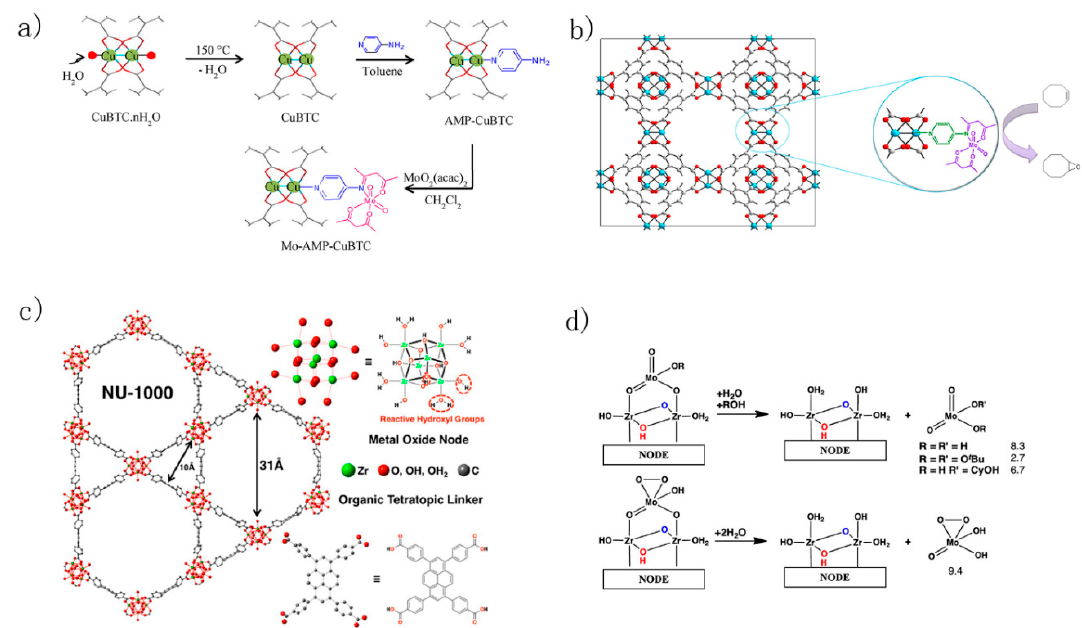
Figure 2. ( a ) The schematic process for modification of CuBTC with molybdenum complexes; ( b ) Structure and epoxidation process of molybdenum containing CuBTC catalysts. Reproduced with permission from reference [58]. Elsevier (2015). ( c ) Schematic illustration of nonmetalated NU-1000 with triple pore sizes and structures of metal oxide node and organic linker; ( d ) Thermodynamics of the leaching process of Mo-SIM. ∆ G tol in kcal/mol. Reproduced with permission from reference [59]. ACS Publications (2016).